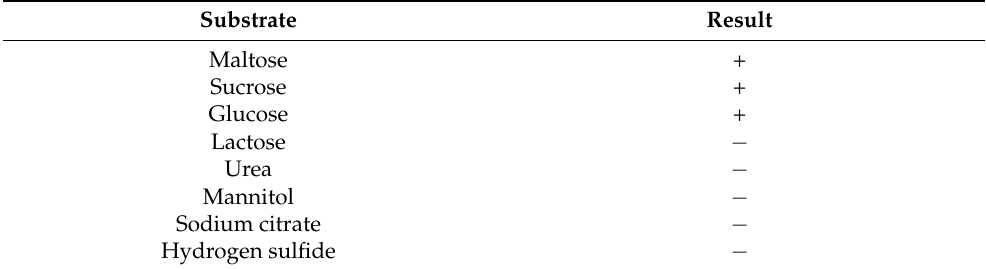
Table 3. Bacterial biochemical